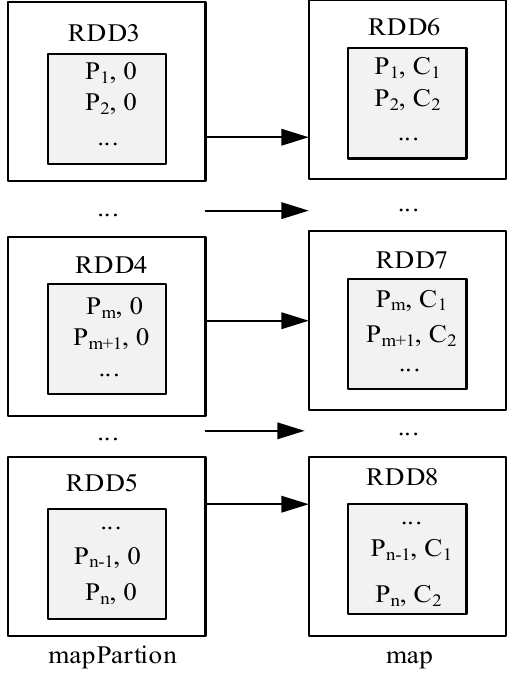
Figure 10. RDD conversion flowchart in the local clustering stage.